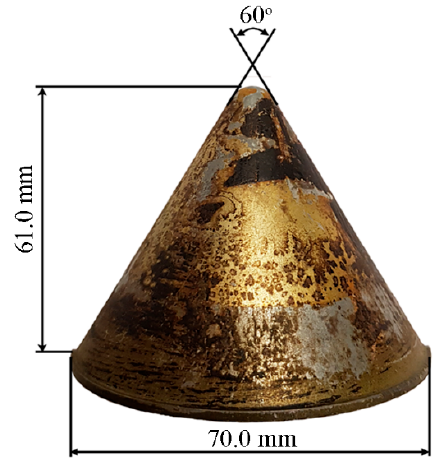
Figure 4. Liner geometry.